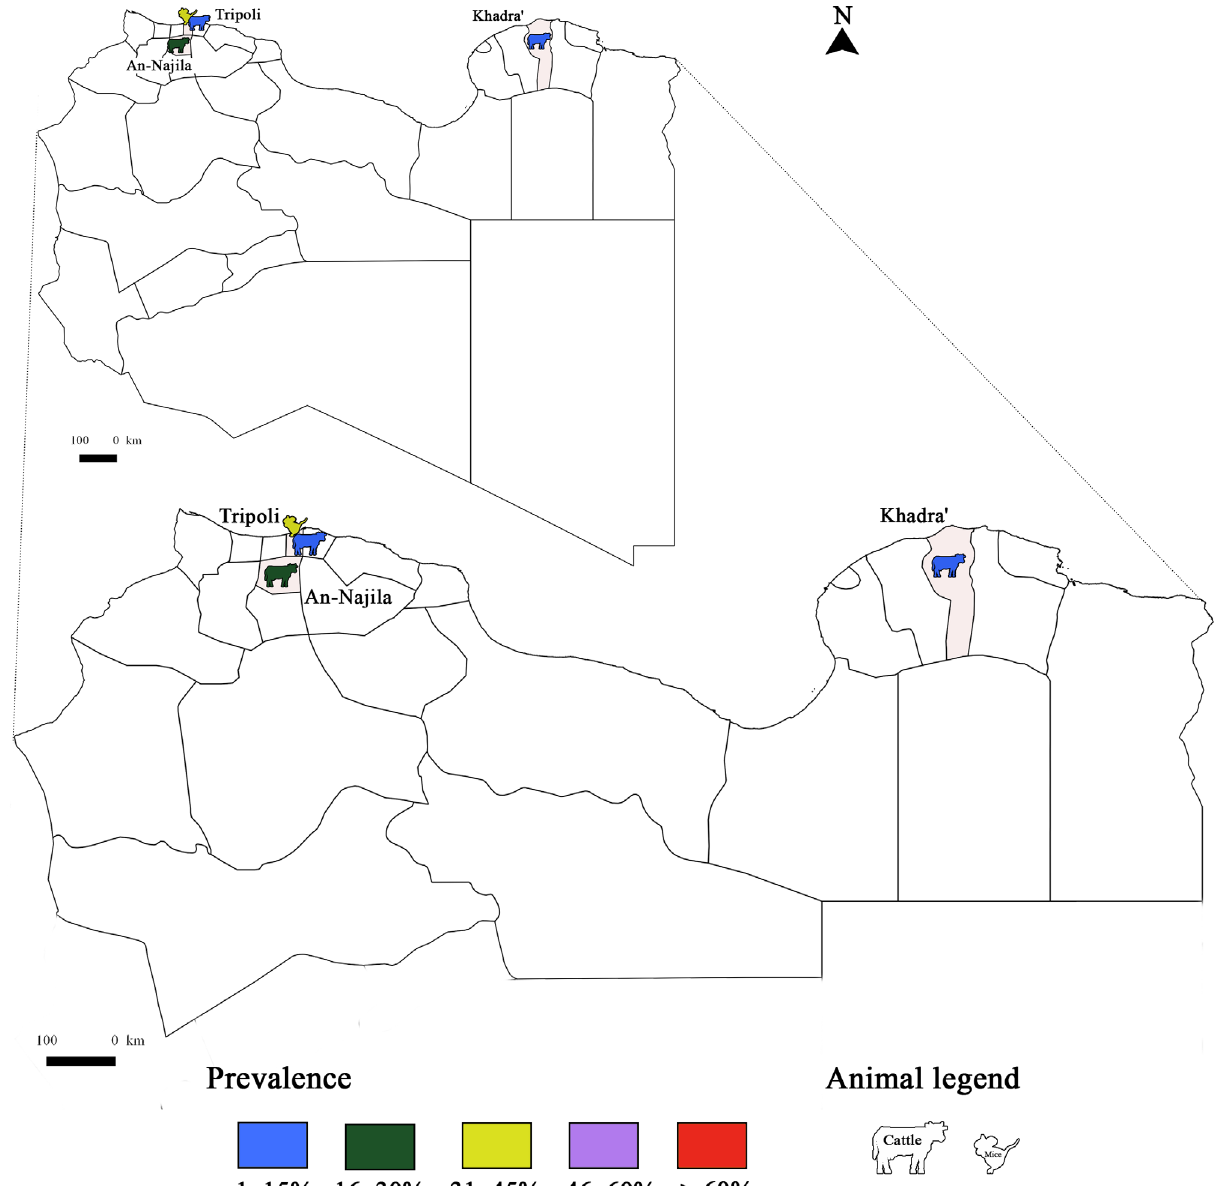
Figure 5. Prevalence of Toxoplasma gondii infection in Libya: Animal toxoplasmosis